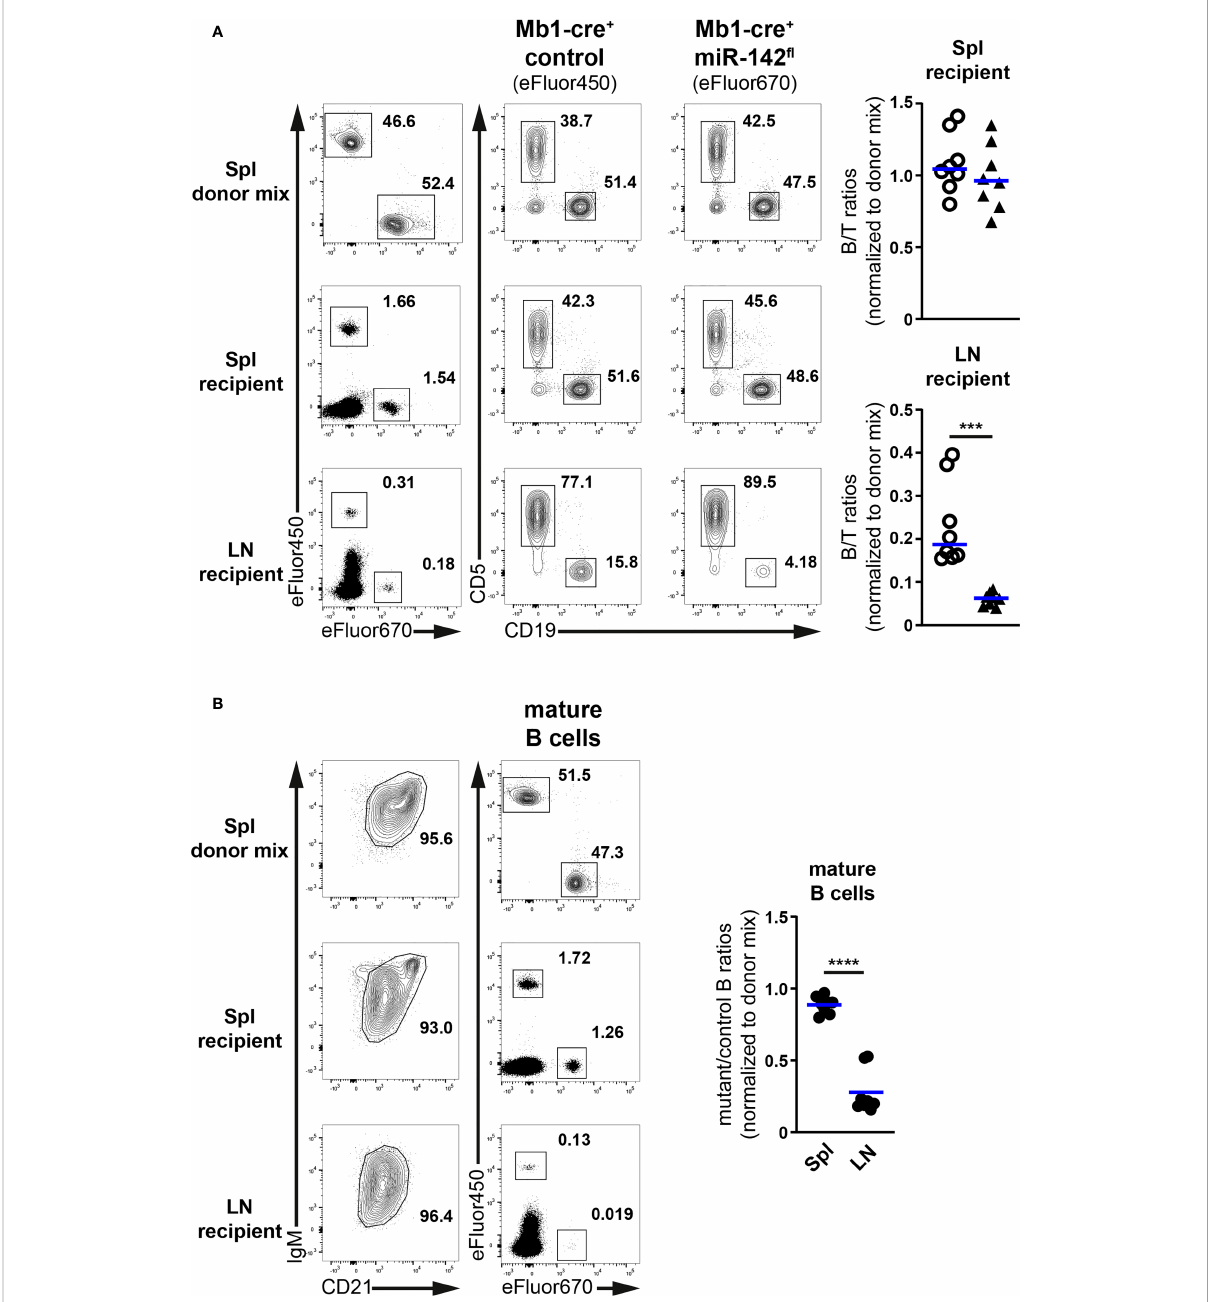
FIGURE 6 Limited accumulation of miR-142-de fi cient B cells in normal peripheral lymph nodes. (A) Left: fl ow cytometry of CD5 + T and CD19 + B cells within Cell proliferation Dye eFluor450 (Mb1-cre + control) and eFluor670 (Mb1-cre + miR-142 fl ) labelled cells in the splenocyte (Spl) donor mixes, as well as in the spleens (Spl) and lymph nodes (LN) of the recipient animals after adoptive transfer. Right: B/T ratios within cells from Mb1-cre + control ( ○ ) and Mb1-cre + miR-142 fl ( ▲ ) mice present in the spleens and lymph nodes of the recipient mice. Normalized to B/T ratios of the donor mixes. (B) Left: FACS analysis of labelled Mb1-cre + control (eFluor450) and mutant (eFluor670) within CD19 + B220 + CD93 – IgM +/hi CD21 +/hi mature B cells in the splenocyte donor mixes, as well as in the spleens and lymph nodes of the recipient animals. Right: mutant/control ratios within mature B cells in the spleens and lymph nodes of the recipients. Normalized to mutant/control mature B cell ratios of the corresponding donor mixes. (A, B) Cumulative of 4 independent donor mixes (Mb1-cre + control/Mb1-cre + miR-142 fl ) injected in 2 recipient mice each and performed in two separate experiments. Each symbol indicates one recipient mouse. Horizontal blue lines signify the means. ***, P ≤ 0.001; ****, P ≤ 0.0001 by Student ’ s t